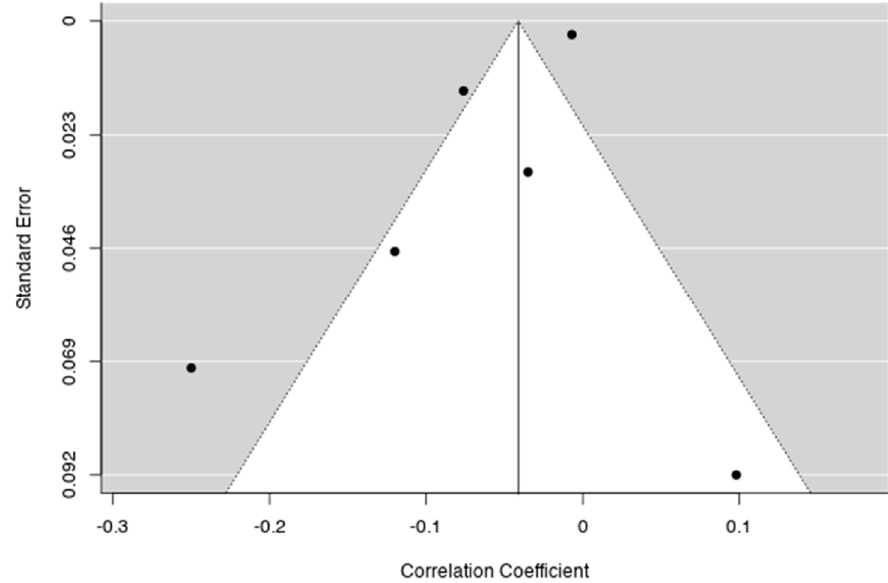
Figure 1. Forest plots of correlation between the genetic risk of schizophrenia and cognition in general and healthy participants. Error bars represent the 95% confidence intervals of the mean.